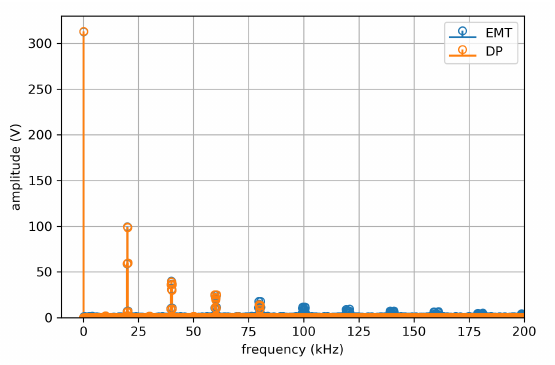
Figure 14. Spectrum of the DP inverter simulation with 28 harmonics as compared to Simulink